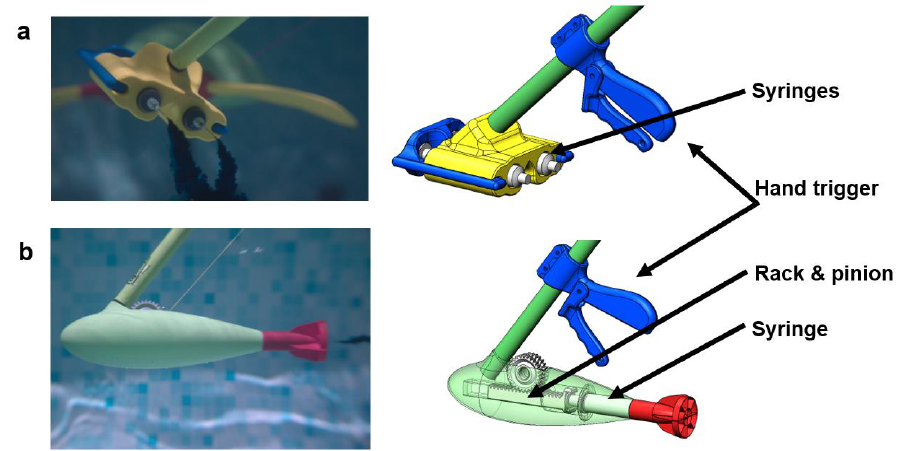
Figure 6. The 3D-printed flow test equipment. ( a ) Dual-injection tool for inserting motionless clouds of dye. Actuation via hand trigger attached via a braided line to a sliding plunger. ( b ) Streamline injection tool to add streamlines of dye into turtle swim path. Actuation via hand trigger attached via a braided line to a rack and pinion mechanism (hand trigger location not in actual position).